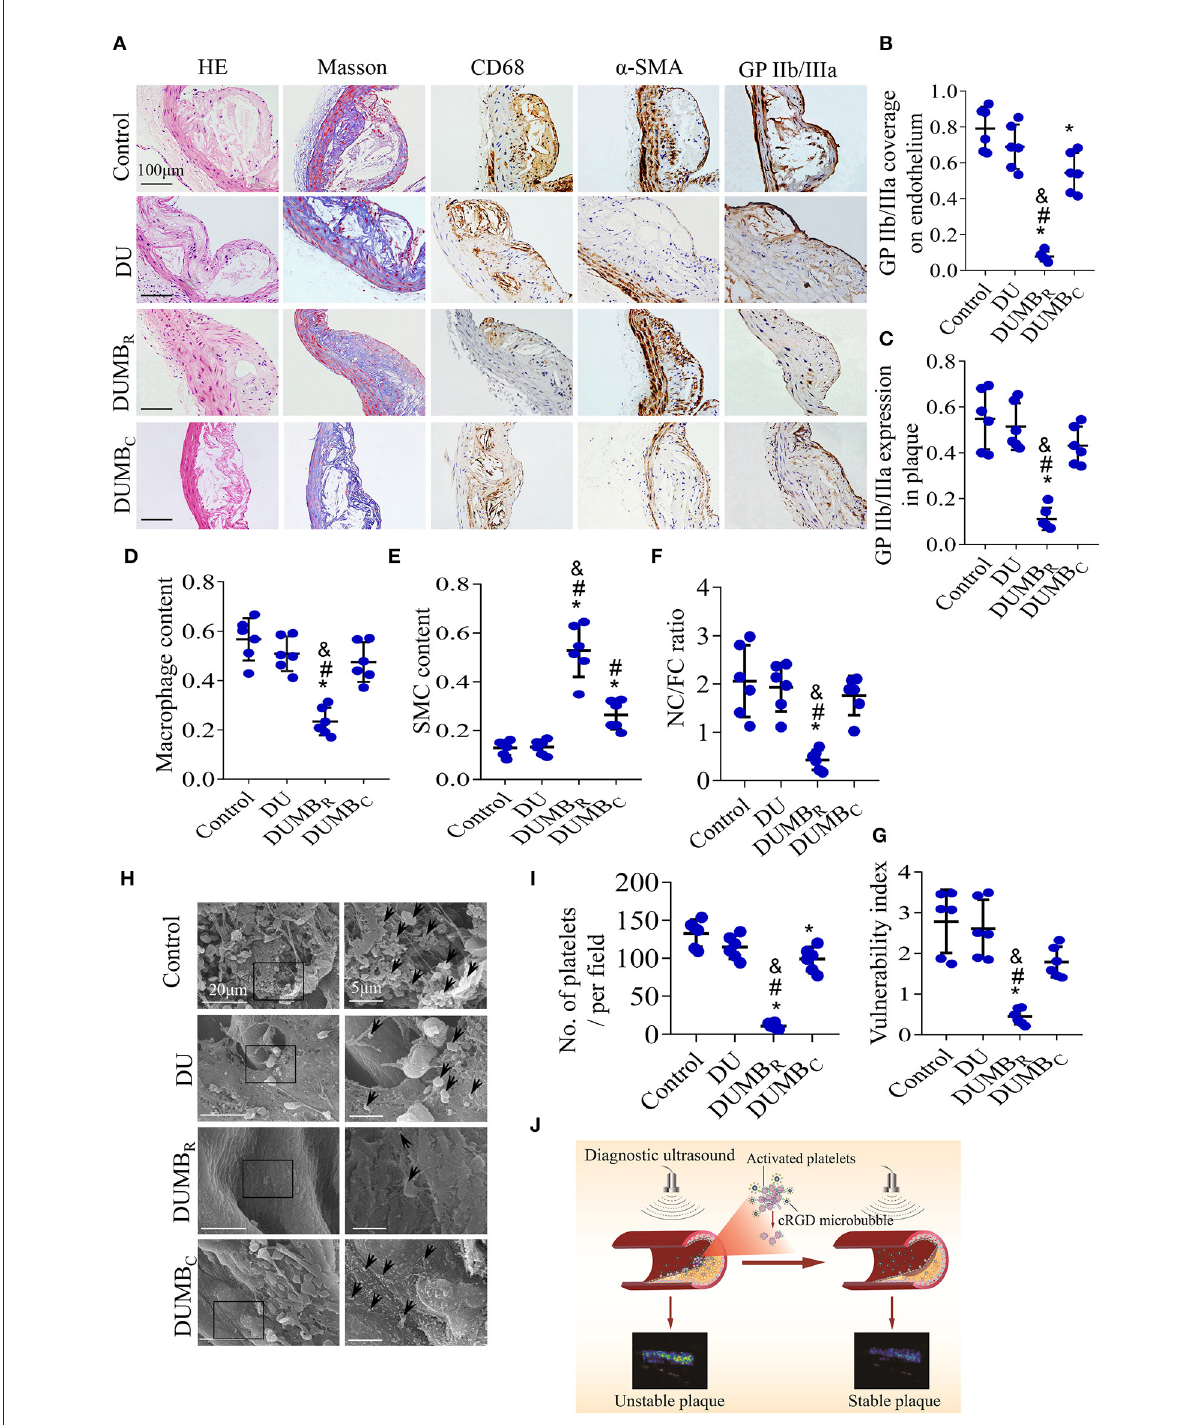
FIGURE7 Effect of DUMB R treatment on plaque instability. (A) Representative images of H & E and Masson’s trichrome staining and immunolabeling with antibodies against α -SMA, CD68 and GP IIb/IIIa. Quantitative analyses of (B) GP IIb/IIIa coverage of the endothelium, (C) total plaque GP IIb/IIIa content, (D) plaque macrophage and (E) SMC content were shown. (F) The plaque NC/FC ratio and (G) vulnerability index were calculated. (H) Representative scanning electron microscopy images of activated platelets (black arrowheads). (I) Average number of activated platelets was quantified. (J) Illustration of DUMB R identifying unstable plaques and simultaneously improving their stability by specifically dissolving activated platelets. n = 6 per group. * P < 0.05 vs. control, # P < 0.05 vs. DU, & P < 0.05 vs. DUMB C . DUMB R , diagnostic ultrasound combined with MB R ; DUMB C , diagnostic ultrasound combined with MB C